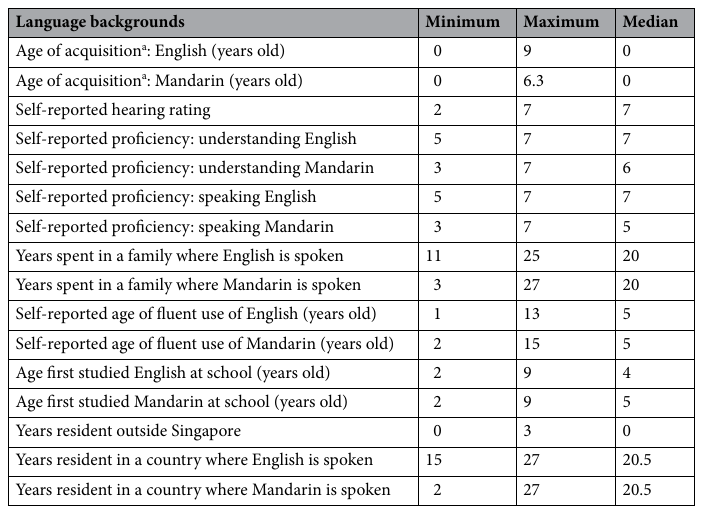
Table 1. Summary of language background data. a Age of Acquisition: “Age when your caregivers started using this language with you”. In cases where question was misinterpreted, youngest age adjusted to